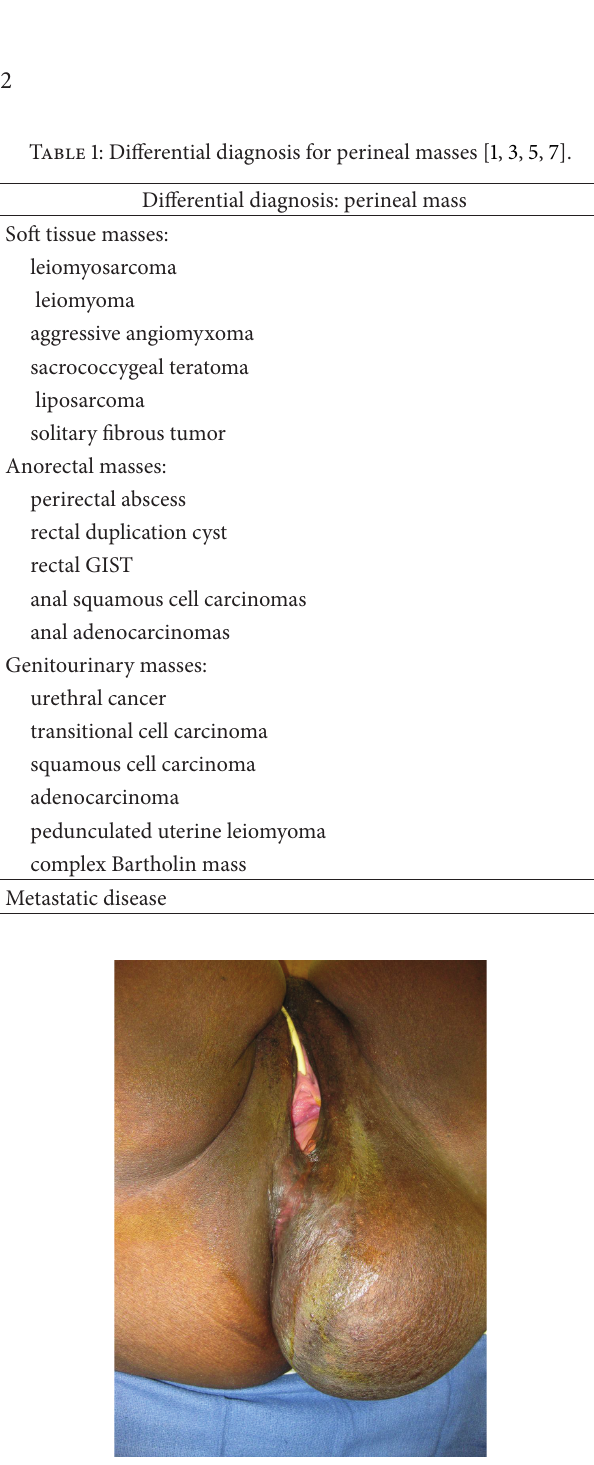
Figure 1: Left perineal mass. Examination of the vagina reveals a bulging mass through the left wall of the vagina but without any direct invasion. Examination of the rectum revealed normal tone with displacement of the left lateral rectal wall towards the midline.